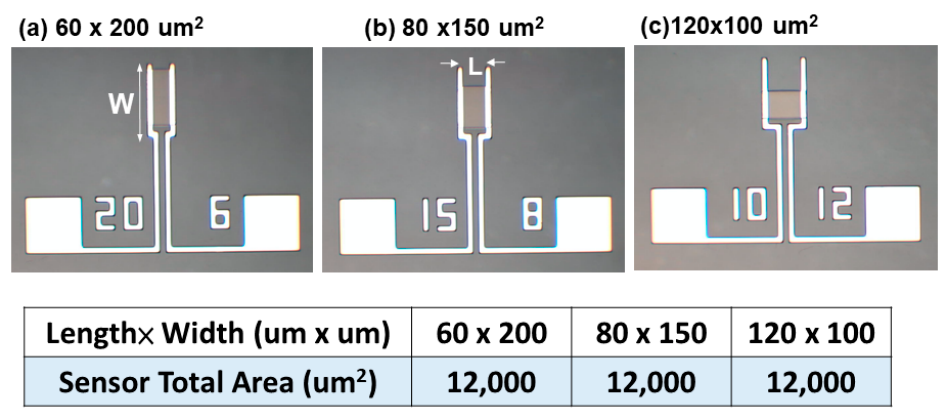
Figure 4. Structures of the devices with a fixed area of 12,000 μ m 2 . The dimensions of the sensing area, L × W, are ( a ) 60 × 200 μ m 2 , ( b ) 80 × 150 μ m 2 , and ( c ) 120 × 100 μ m 2 .